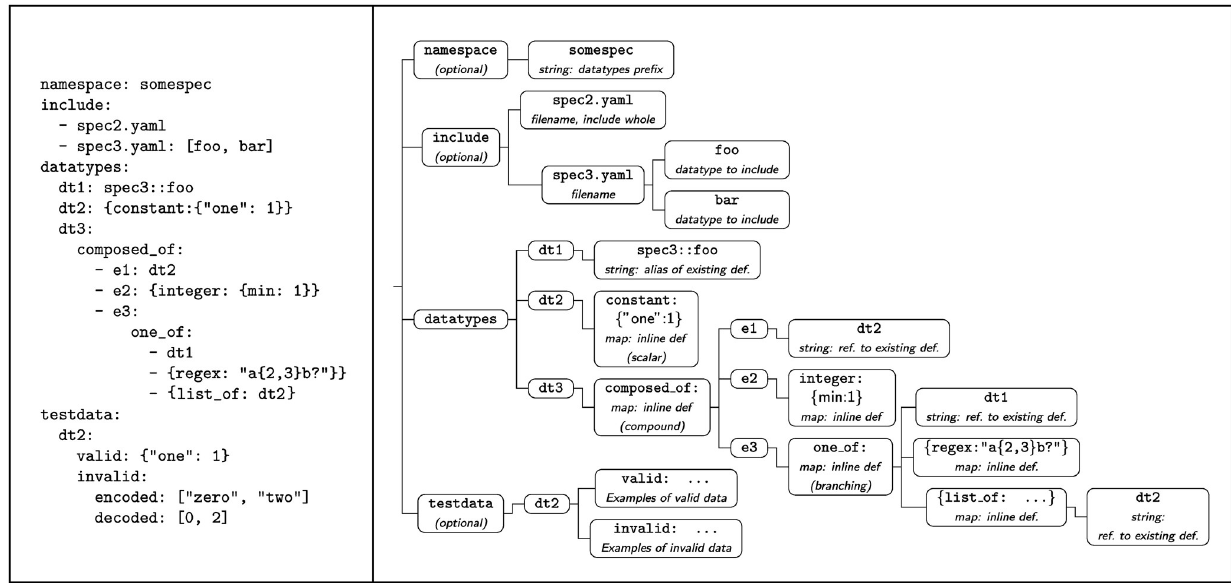
Fig 1. View of a TFSL specification as a tree. An example of TextFormats specification in YAML format (left) and the the information contained in the specification viewed as a tree (right).